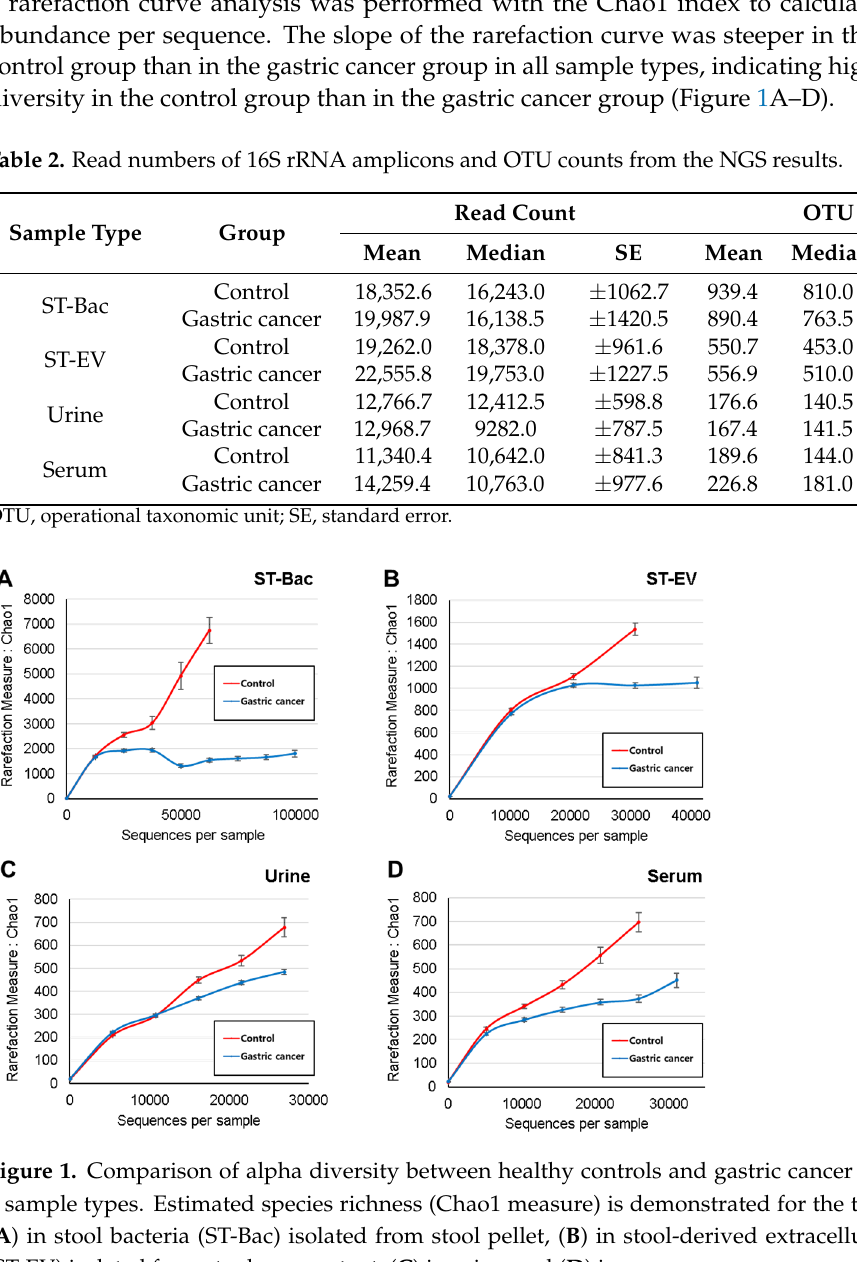
Figure 2. Comparison of beta diversity in phylum and genus levels between healthy controls and gastric cancer patients in 4 sample types. PCoA results based on Bray–Curtis similarity for beta diversity of bacteria are shown ( A ) in phylum level and ( B ) in genus level. 3.3. Relative Abundance Differences between Healthy Controls and Gastric Cancer Patients We compared the relative abundances of microbiome between the control group and the gastric cancer group to identify the taxa that were differentially represented in the two groups of subjects. In the comparison of phylum levels, heatmaps using ST-Bac samples showed that Bacteroidetes were reduced, while Firmicutes were increased in gastric cancer (Figure 3A, Figure S2A). In ST-EV samples, Bacteroidetes were reduced, while Actinobacte- ria were increased in gastric cancer (Figure 3B, Figure S2B). In urine samples, Bacteroidetes